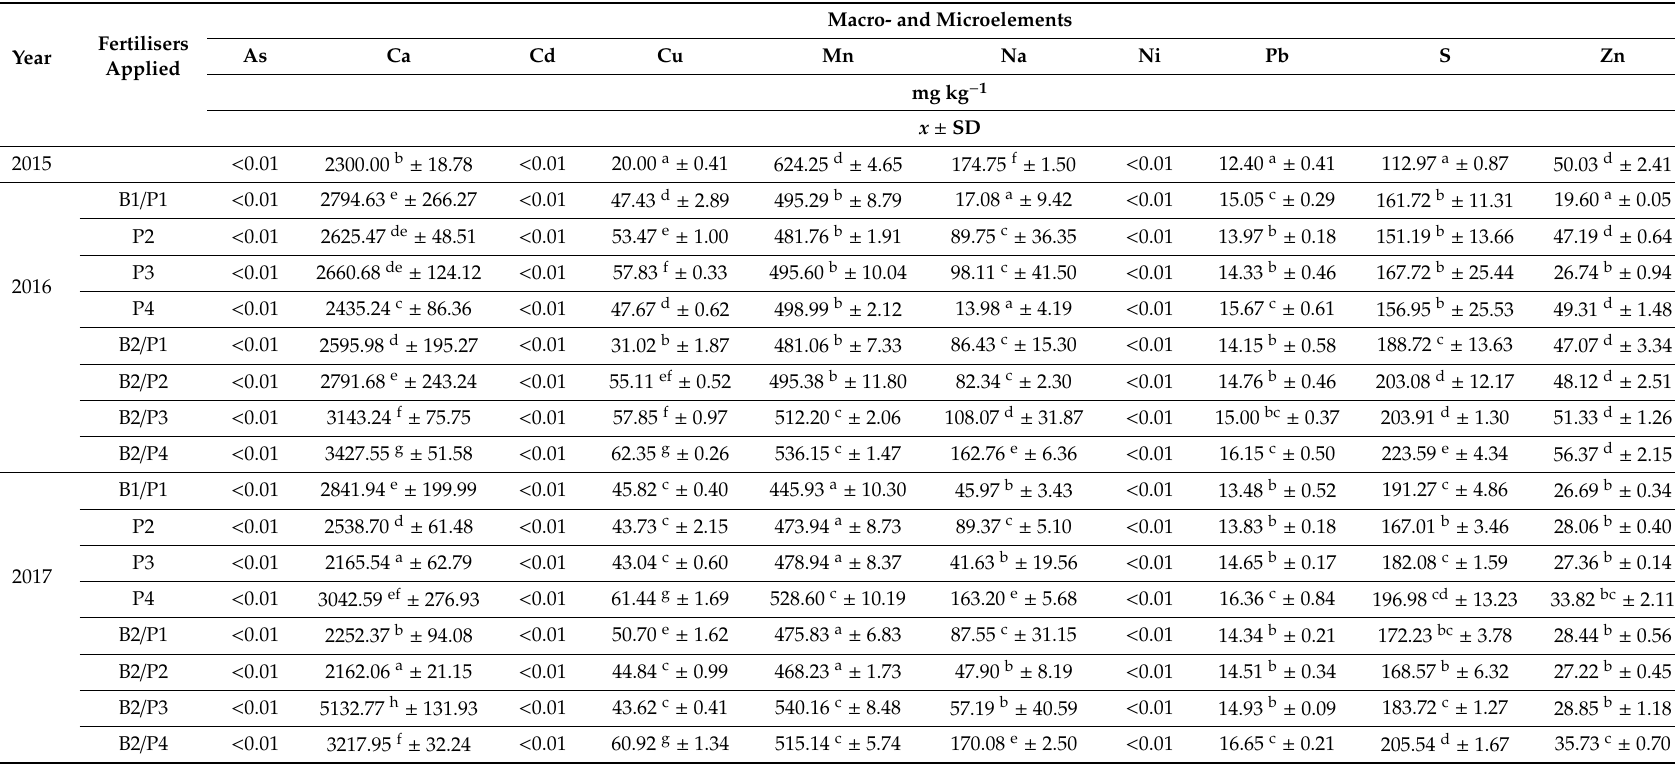
Table 6. Contents of selected macro- and micro-elements and heavy metals in the soil prior to the experiment as well as following the first and second years of cultivation, in relation to the fertilisers